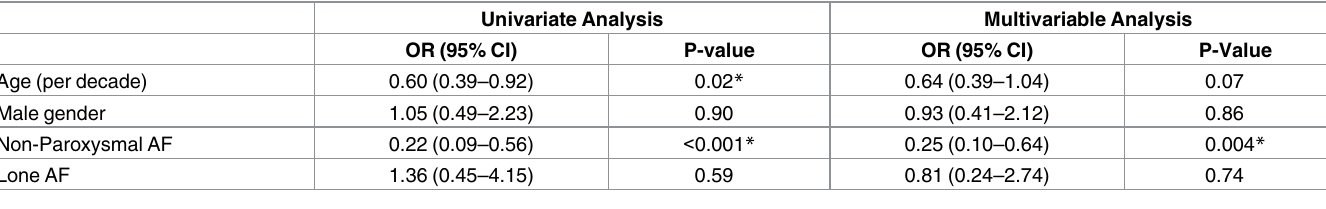
Table 2. Association between Baseline characteristics and PV reconnection